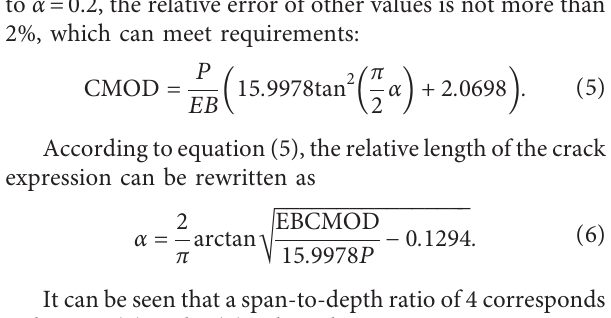
Figure 4: Stress components at crack tip shown in the rectangular coordinate